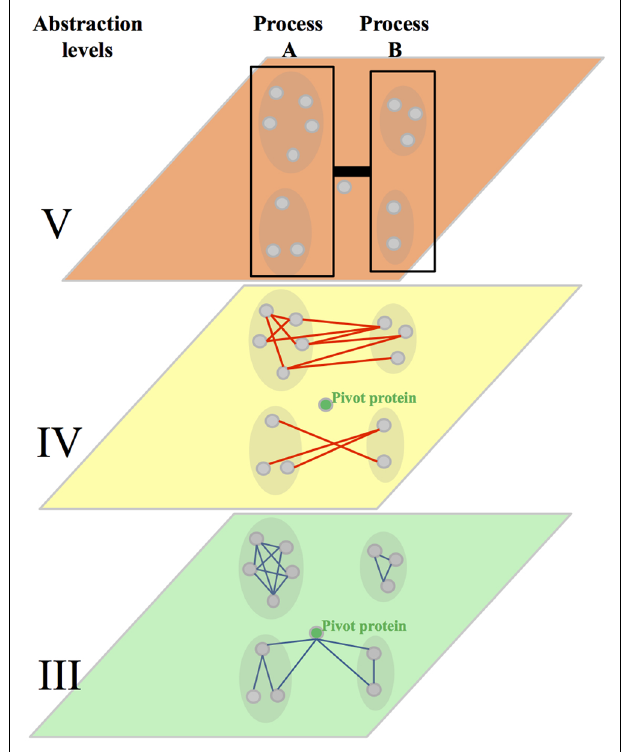
FIGURE 5 | Integration of the abstraction level III, IV, andV. Abstraction level III shows protein–protein interactions (PPIs, blue edges) within highly connected protein interaction modules. It represents also a pivot proteins highly connected with proteins of two dense modules.The abstraction level IV shows the connection of dense protein modules through genetic interactions (GIs, red edges, between pathway model). It shows also the approximate rate of within pathway and between pathways GIs observed in yeast.The levelV shows the clustering of dense modules in biological processes and the link brought by GIs between these processes.The strength of that link is more evolutionary conserved than individual GIs at the abstraction level